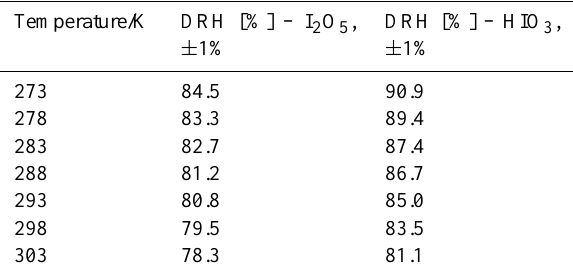
Table 3. Measured values of deliquescence relative humidity (DRH) for I 2 O 5 and HIO 3 crystals from 273–303K.